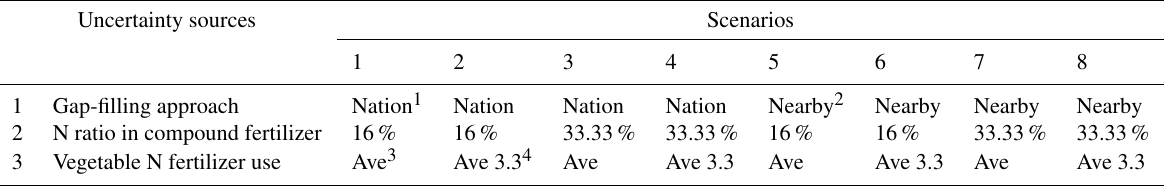
Table 2. The eight scenarios considered in reconstructing nitrogen (N) fertilizer use in China. Uncertainty